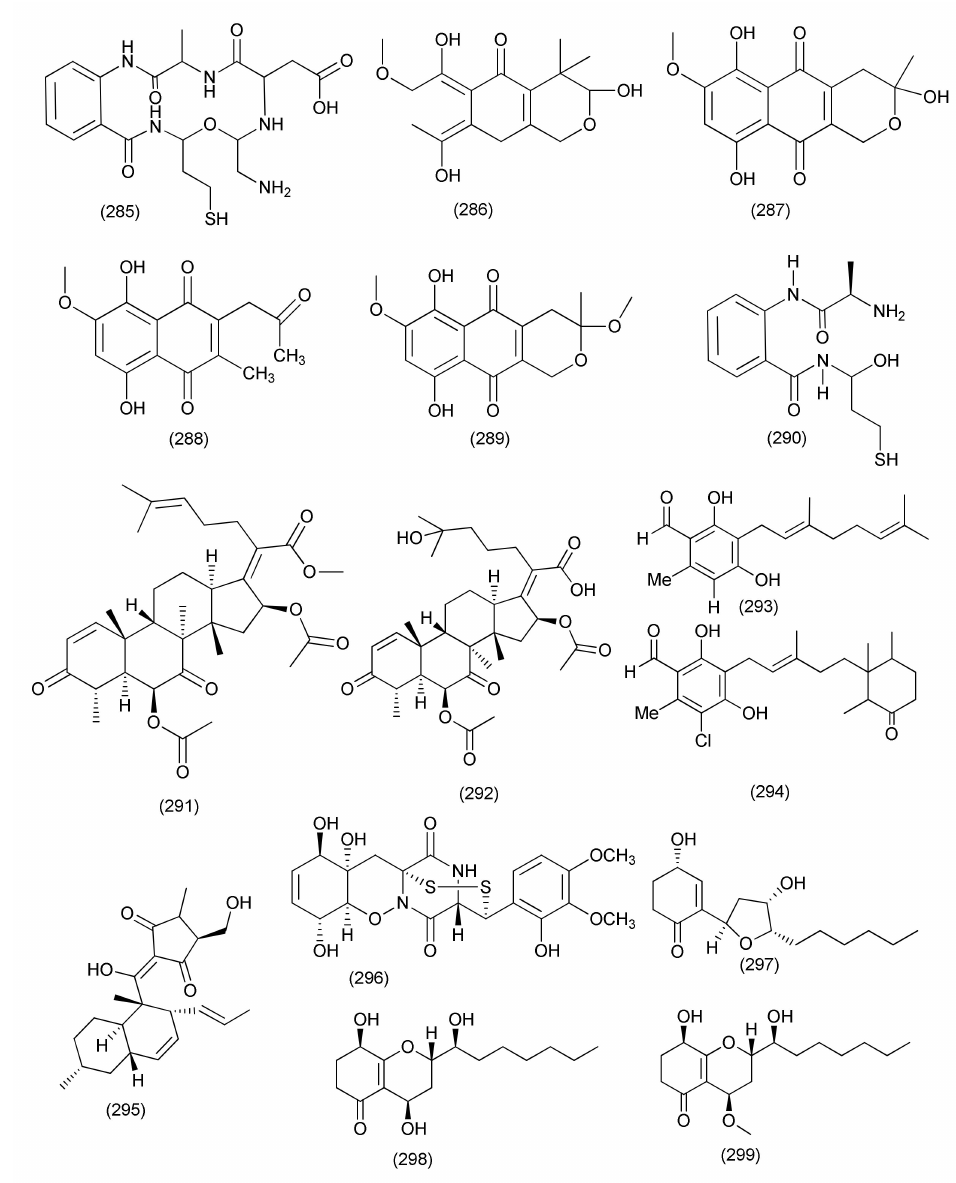
Figure 16. Structures of metabolites 285 – 299 isolated from Anamorphic